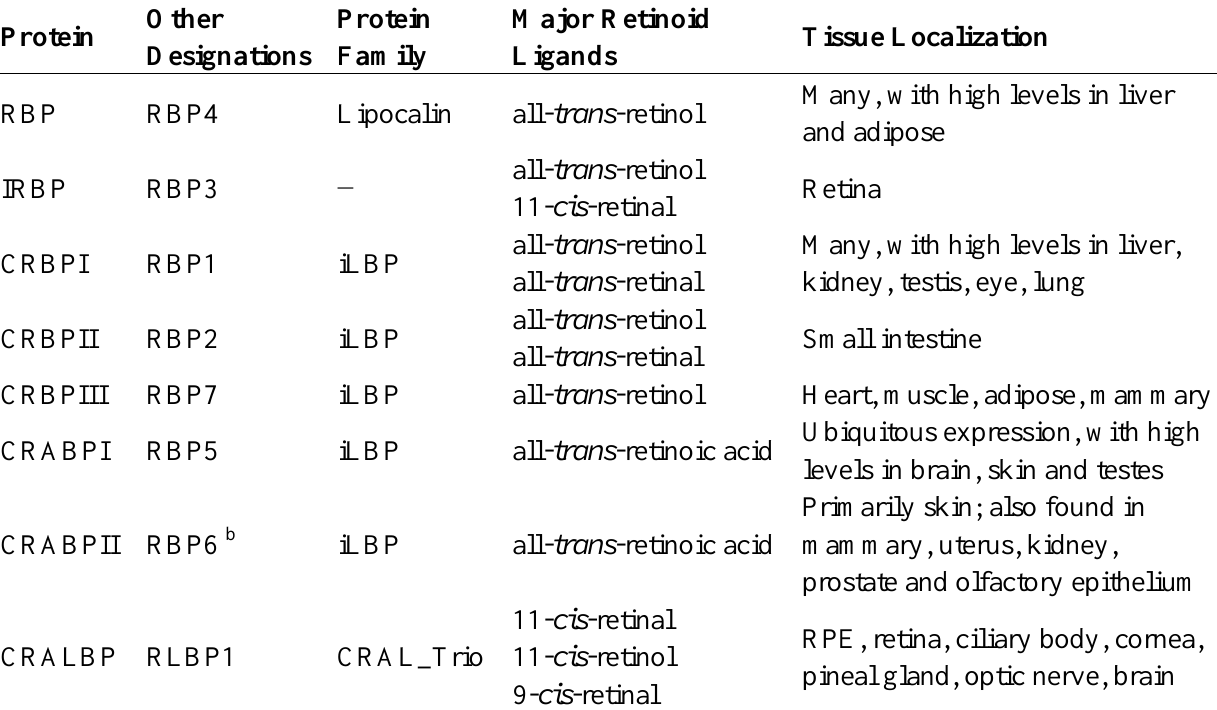
Table 1. Retinoid-binding proteins in the adult mouse a